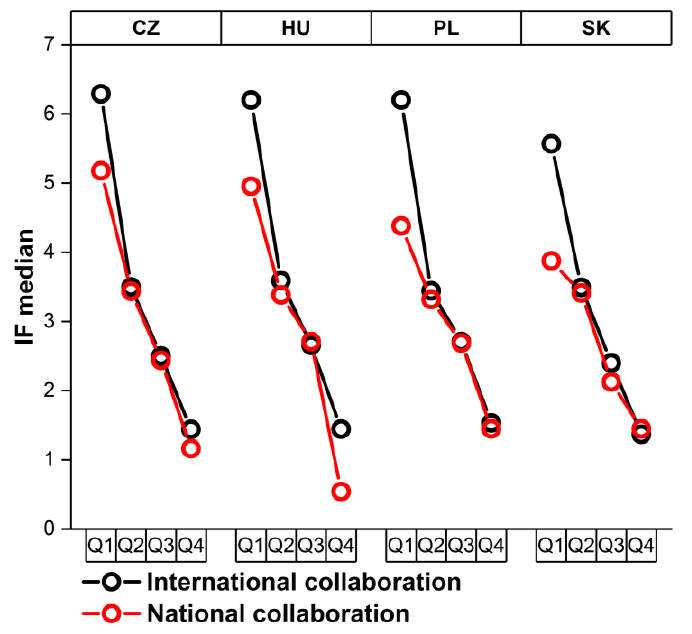
Figure 2. Comparison of JIF of research papers published in Q1–Q4 journals by V4 countries, as a function of collaboration type. The Y corresponds to the median level of JIF. Abbreviations: CZ = Czech Republic, HU = Hungary, PL = Poland, SK = Slovakia. Table 2. The observed levels of significance when comparing the impact factor of research papers published in international and national collaboration.